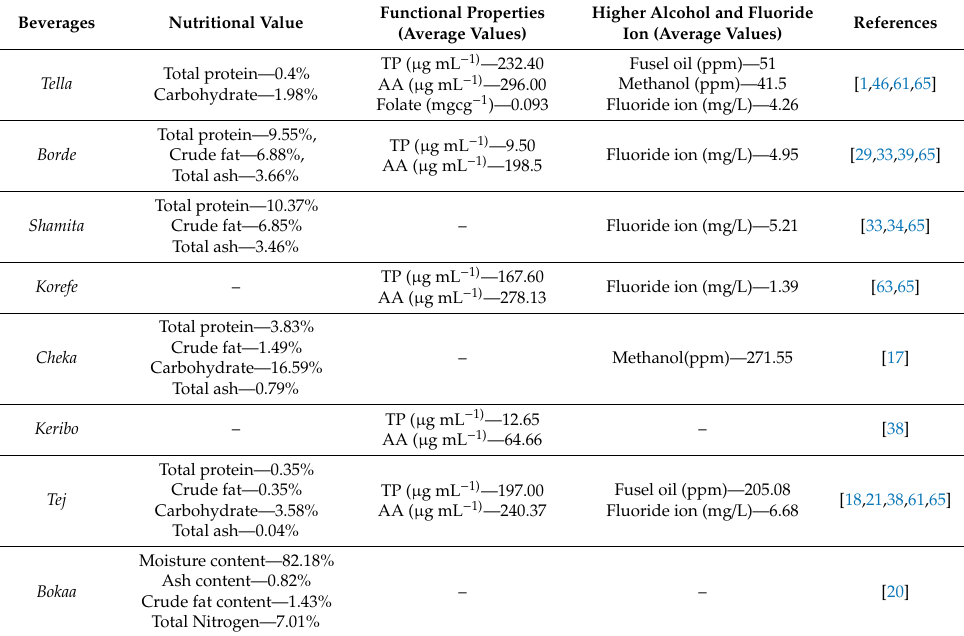
Table 5. Nutritional value, functional properties and safety issues of Ethiopian alcoholic